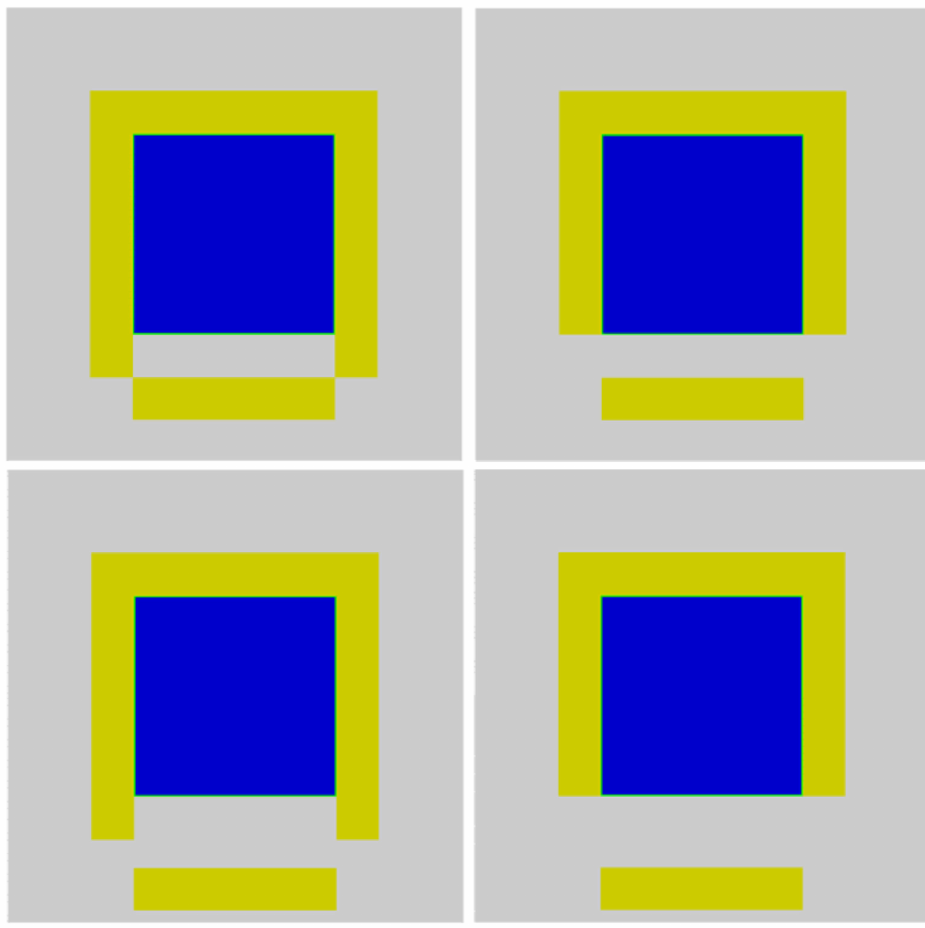
Figure 5. Different cases investigated for the study of the shutdown system moving the bottom reflector away from the core (top left—case 1 (reference), top right—case 2, bottom left—case 3, bottom right—case